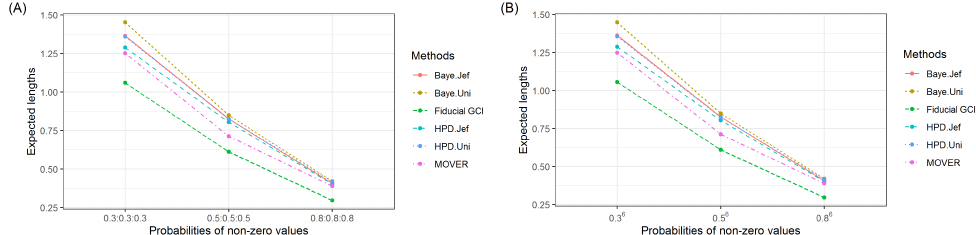
Figure 5. Expected lengths of the 95% simultaneous CIs with various probabilities of nonzero values: ( A ) k = 3 and ( B ) k =